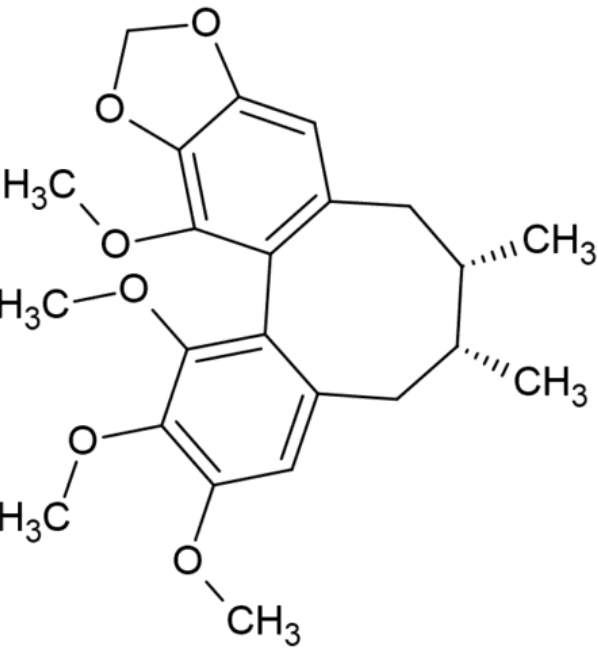
Figure 1. The chemical structure of Schisandrin B.